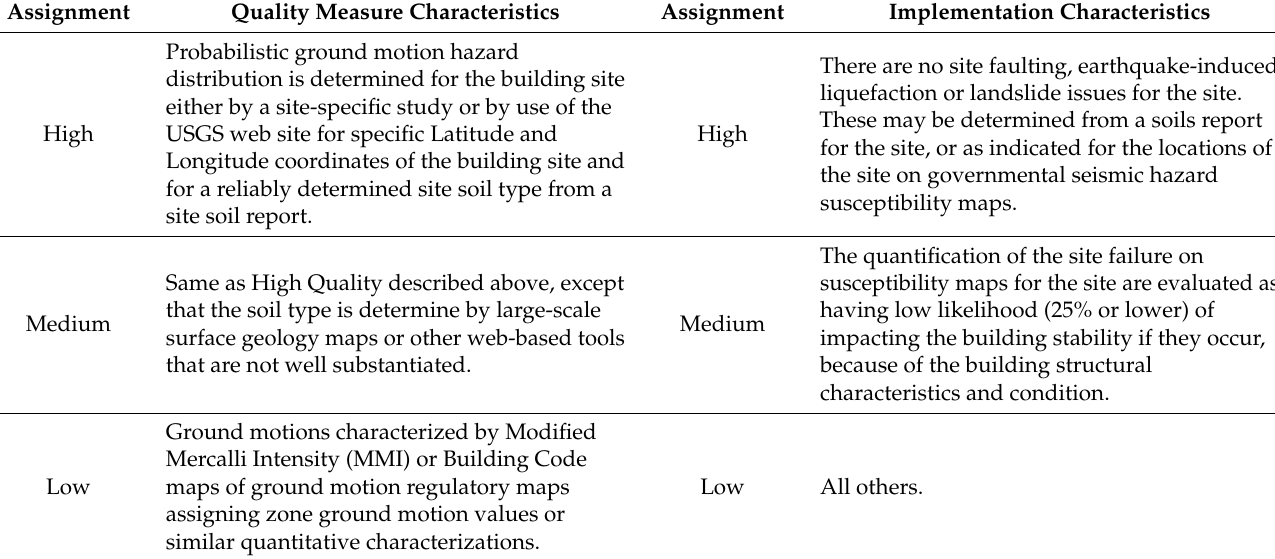
Table 3. Each of the nine components listed in this Section require assessment using Table 1 for the assessed quality of the component β i , where i is the component issue under discussion. The following matrices describe Table 41. These considerations are intended to assess both the principal and secondary influences that impact the resulting damageability and stability of the building. It is prudent to check the resulting determination as discussed in Section 4 and possibly reconsider the assignments for individual items based on these observations. References are made to ASCE 41 ground motions BSE-1E and BSE-2E, which are, respectively, the probabilistic ground motions with 20% and 5% probability of exceedance in 50 years. See Tables 1 and 2 for the assignment of the β i